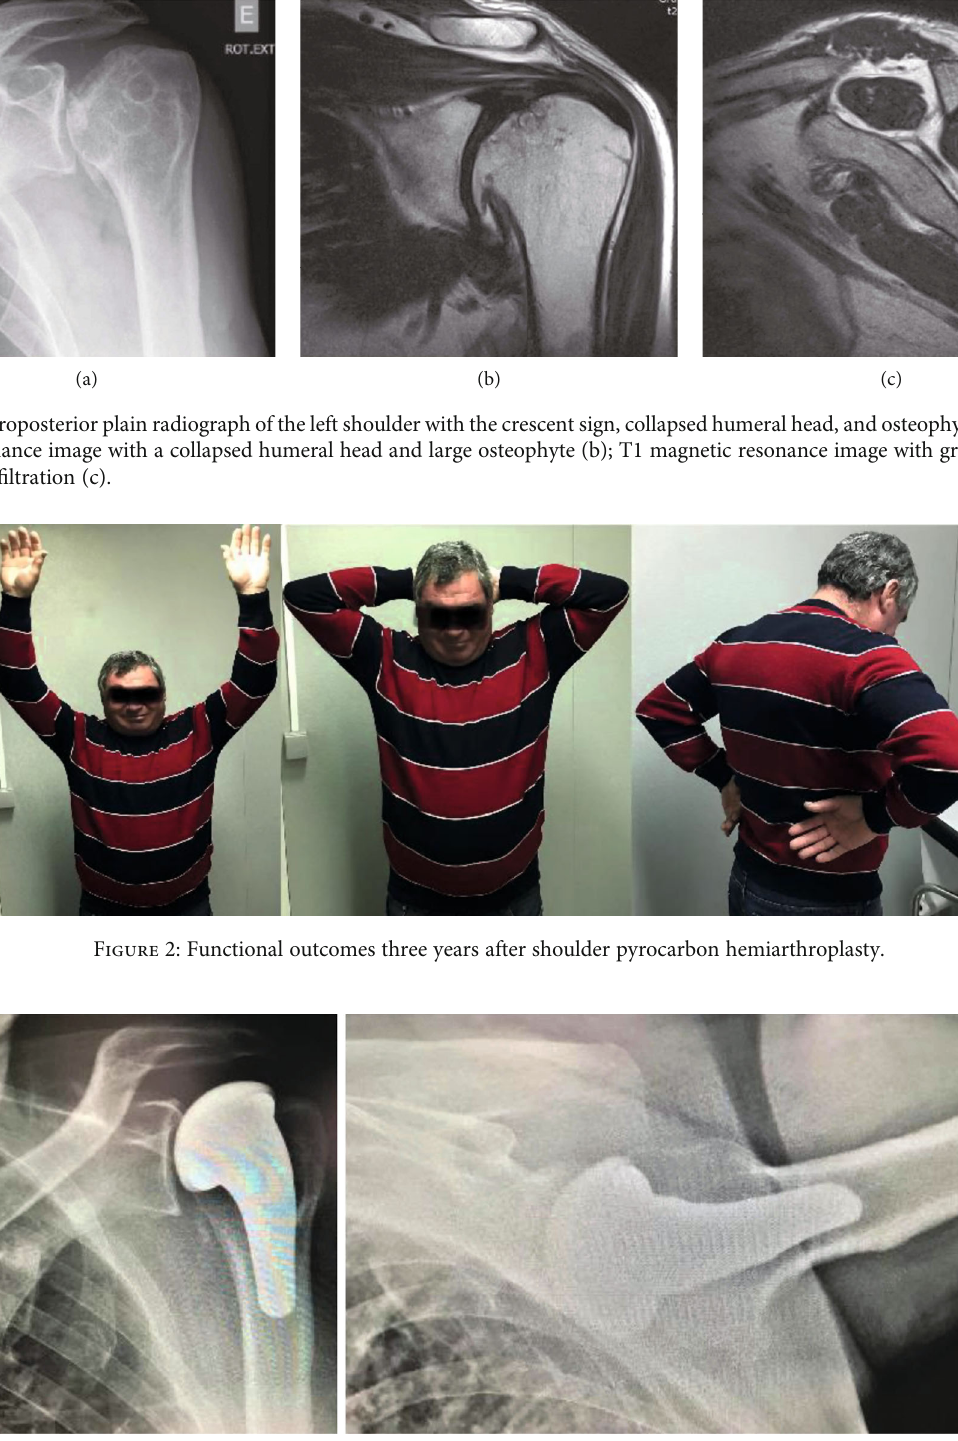
Figure 3: Plain radiographs of the left shoulder with good implantation of the humeral steam and no evidence of glenoid erosion.